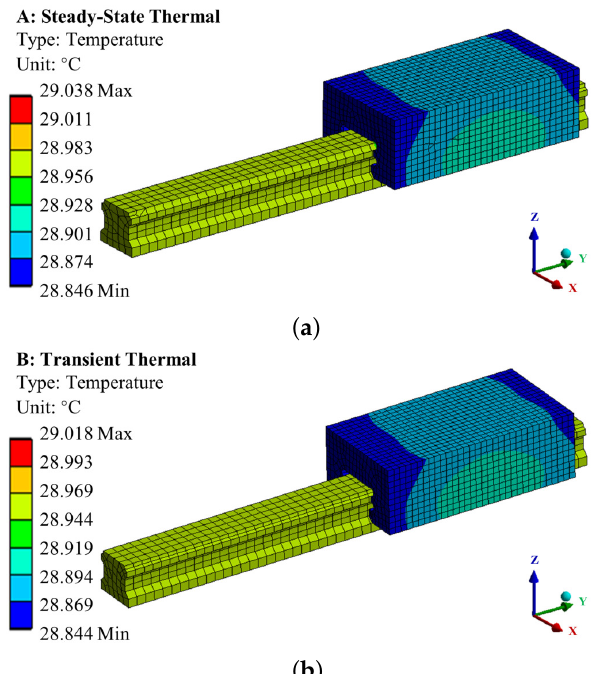
Figure 4. Thermal analysis of the LRG: ( a ) Steady-state and ( b ) transient thermal analysis.